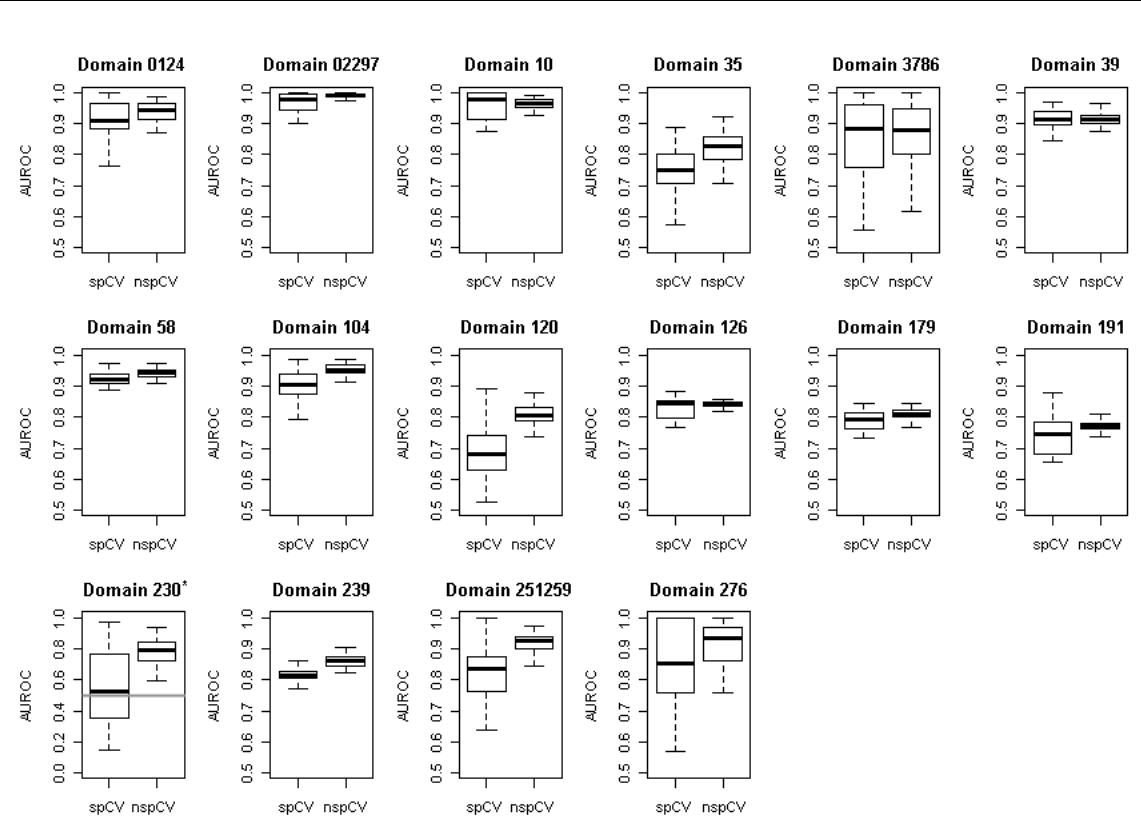
Fig. 5. Box plots showing the range of AUROC values resulting from repeated k -fold cross-validation with spatial subsampling (spCV) and Figure 5. Boxplots showing the range of AUROC values resulting from repeated k- fold cross-2 non-spatial subsampling (nspCV) for each modelling domain. The y axis limits for this domain range from 0 to 1 and a grey line marks the 0.5 validation with spatial subsampling (spCV) and non-spatial subsampling (nspCV) for each 3 modelling domain. *The y-axis limits for this domain range from 0 to 1 and a grey line marks 4 the 0.5 value. 5